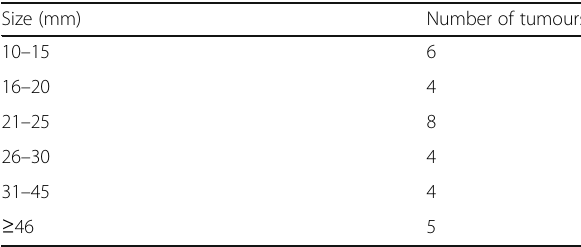
Table 1 Size of renal tumours